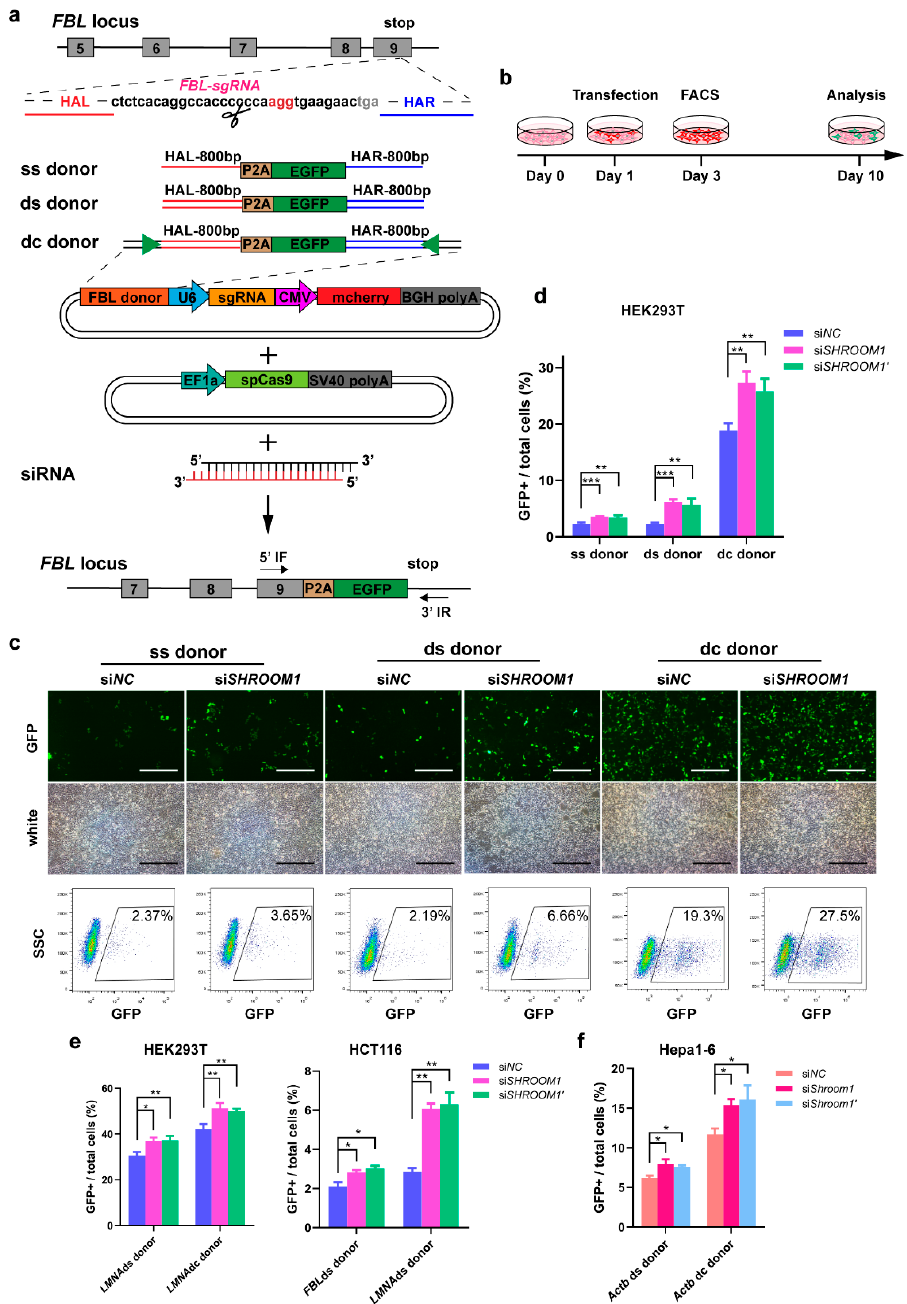
Figure 3. Knockdown of SHROOM1 enhances the knock-in efficiency of cells in vitro. ( a ) Schematic overview of gene-targeting strategies with siRNA and different types of donor at the FBL locus. HAL/HAR, left/right homology arm; triangles, sgRNA target sites; IF/IR, inserted forward/reverse primer. ss, single strand; ds, double strand; dc, double cut. ( b ) Experimental scheme for targeted FBL -2A-GFP knock-in in HEK293T cells. Representative visual fields and sorting charts ( c ) and relative knock-in efficiency ( d ) of ss, ds, and dc donor-based strategies with SHROOM1 siRNA or not at the FBL locus in HEK293T cells. Scale bar, 200 μ m. Data were generated from n = 3 independent experiments. Error bars, ± SD ** p < 0.01; *** p < 0.001 by two-sided Student’s t -test ( e , f ). Relative knock-in efficiency of ds and dc donor-based strategies with siRNA in HEK293T, HCT116, or Hepa1-6 cells. Data were generated from n = 3 independent experiments. Error bars, ± SD * p < 0.05; ** p < 0.01 by two-sided Student’s t -test.